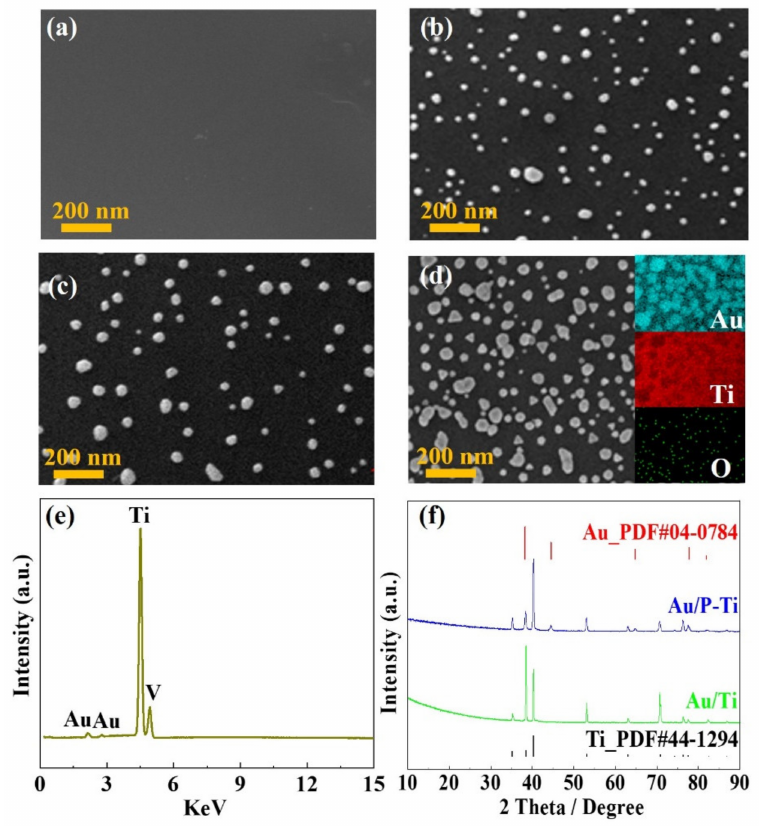
Figure 3. SEM images of ( a ) P-Ti, and Au/P-Ti prepared with different electrical pulse times: ( b ) 4 min, ( c ) 6 min and ( d ) 8 min, the insert is the corresponding EDS element mapping for Au, Ti and O, ( e ) EDS spectrum of the Au/Ti (6 min), ( f ) XRD patterns of the Au/P-Ti (6 min) and